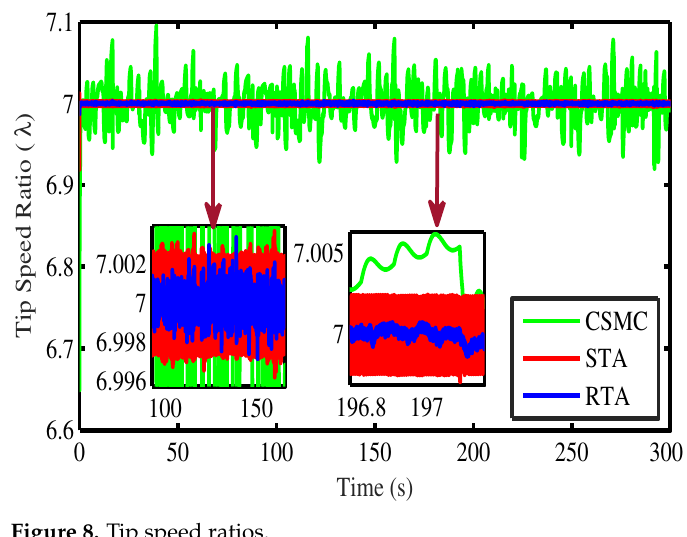
Figure 8. Tip speed ratios.